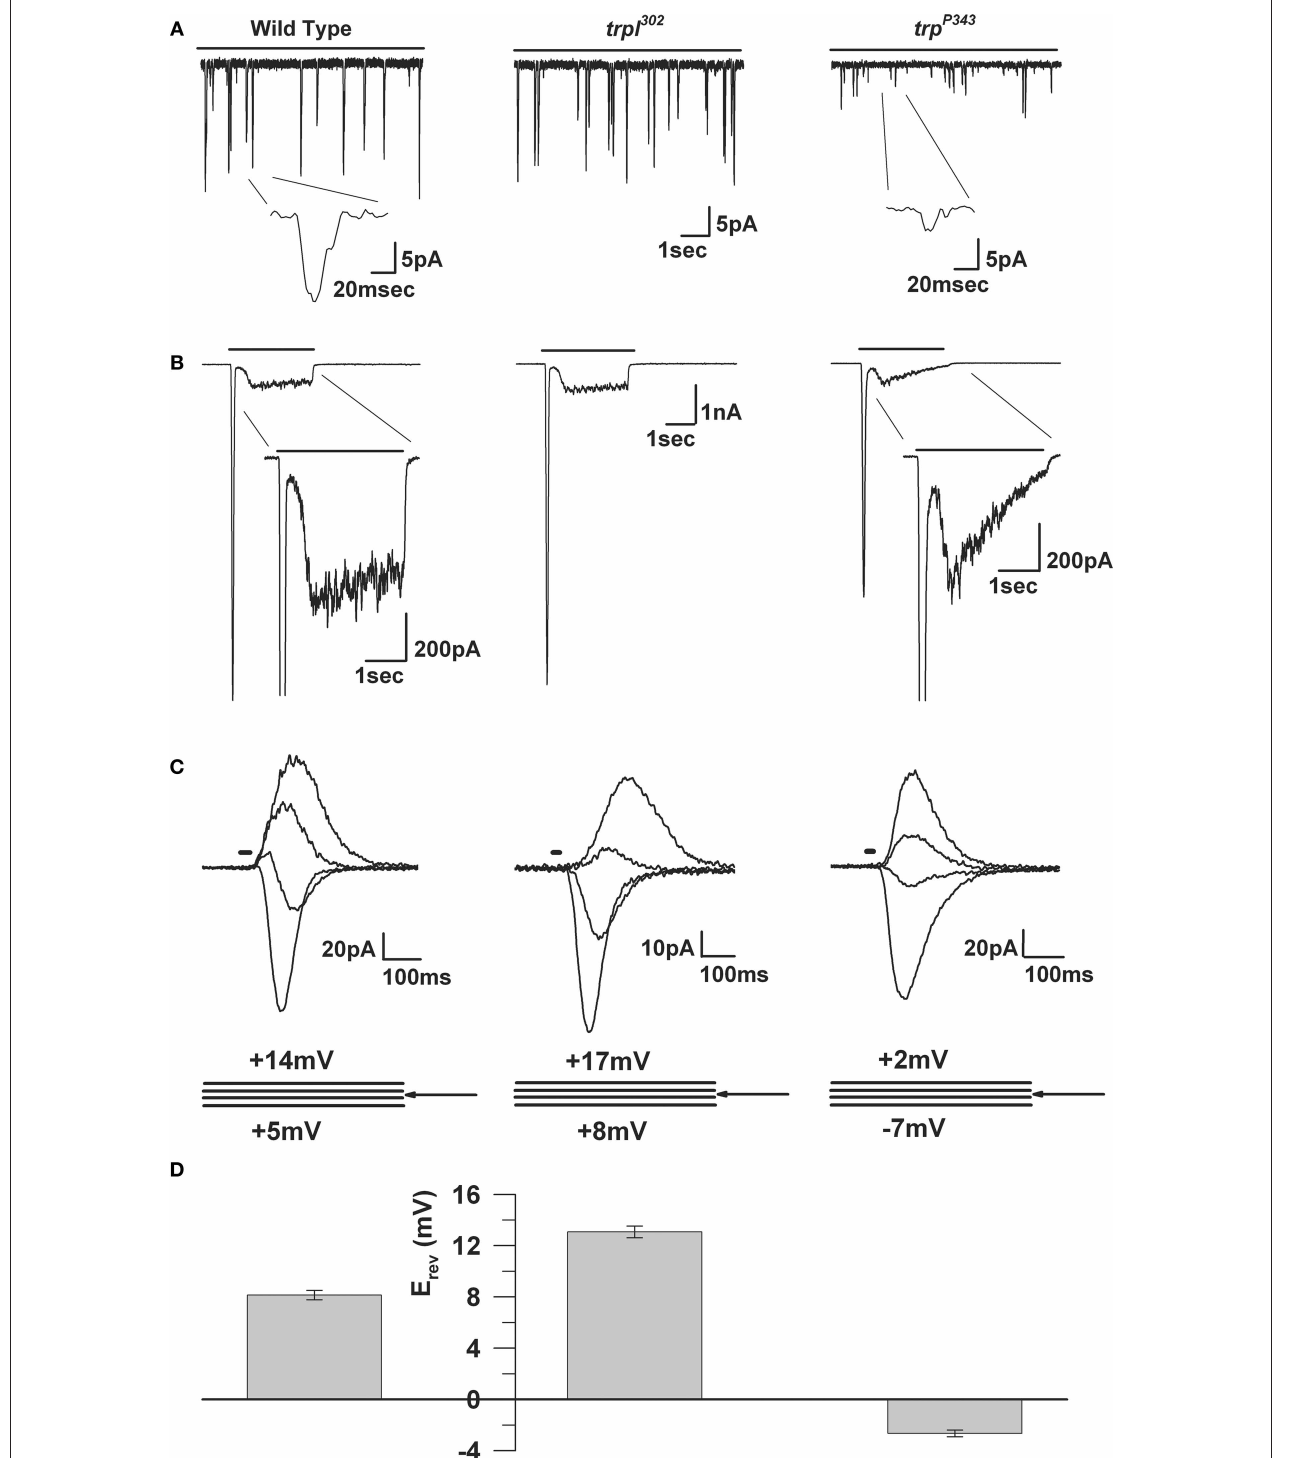
FIGURE 10 | The electrophysiological properties of WT, trp and trpl mutants. (A) Whole-cell voltage clamp recordings of quantum bumps in response to continuous dim light in wild-type, trpl 302 and trp P343 null mutant fl ies. Highly reduced amplitude of trp P343 bumps is observed. (B) Whole-cell voltage clamp recordings in response to a 3-s light pulse of WT and the corresponding mutants. The transient